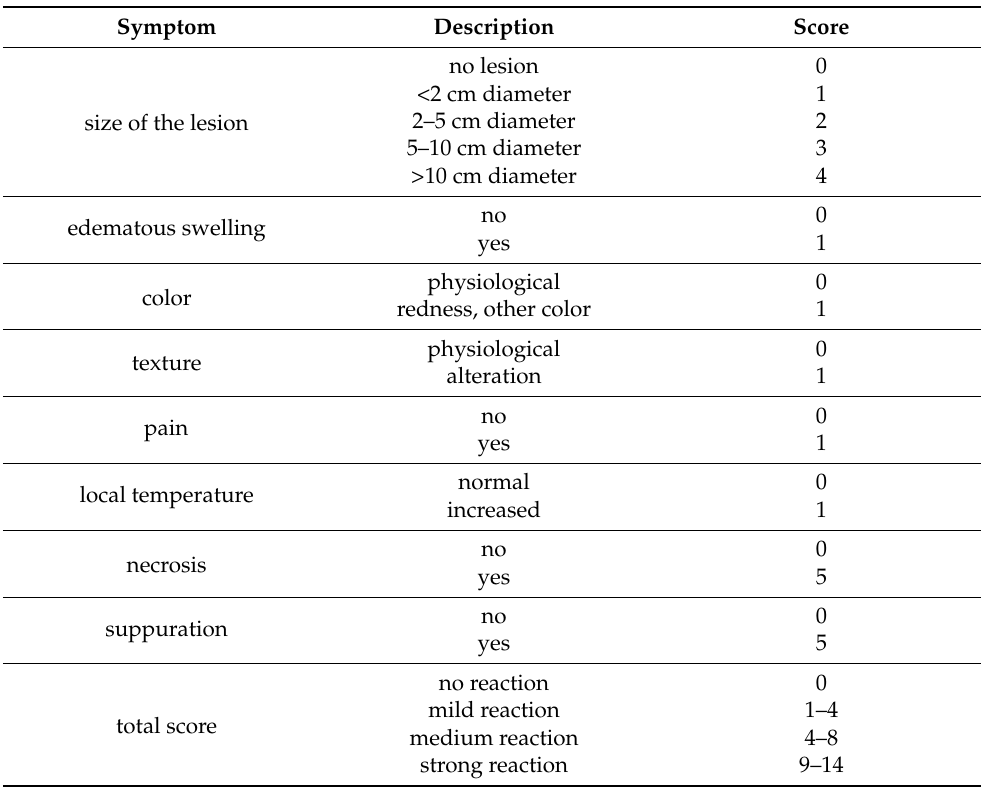
Table 3. Scoring system of local lesions at the injection sites. Symptom